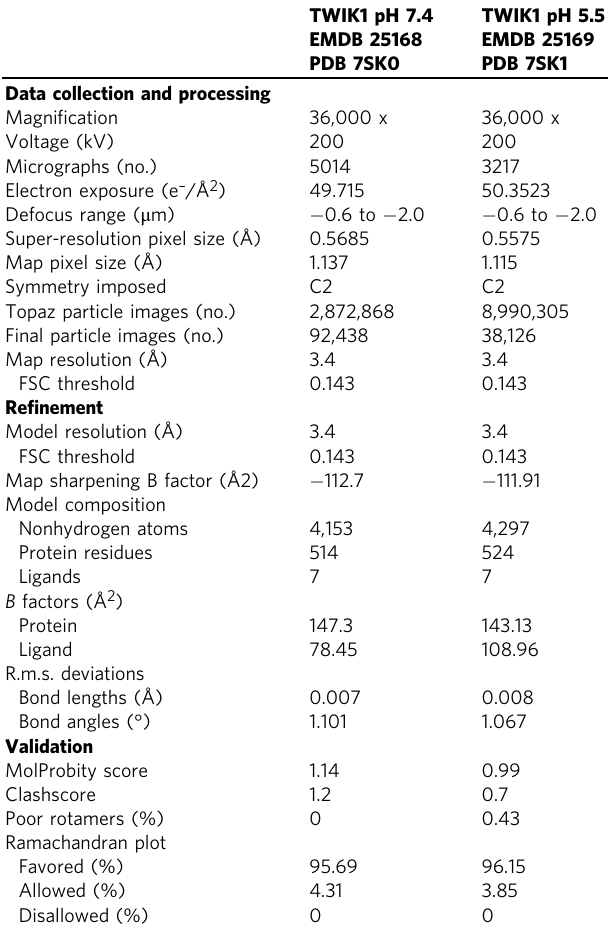
Table 1 Cryo-EM data collection, re fi nement, and validation